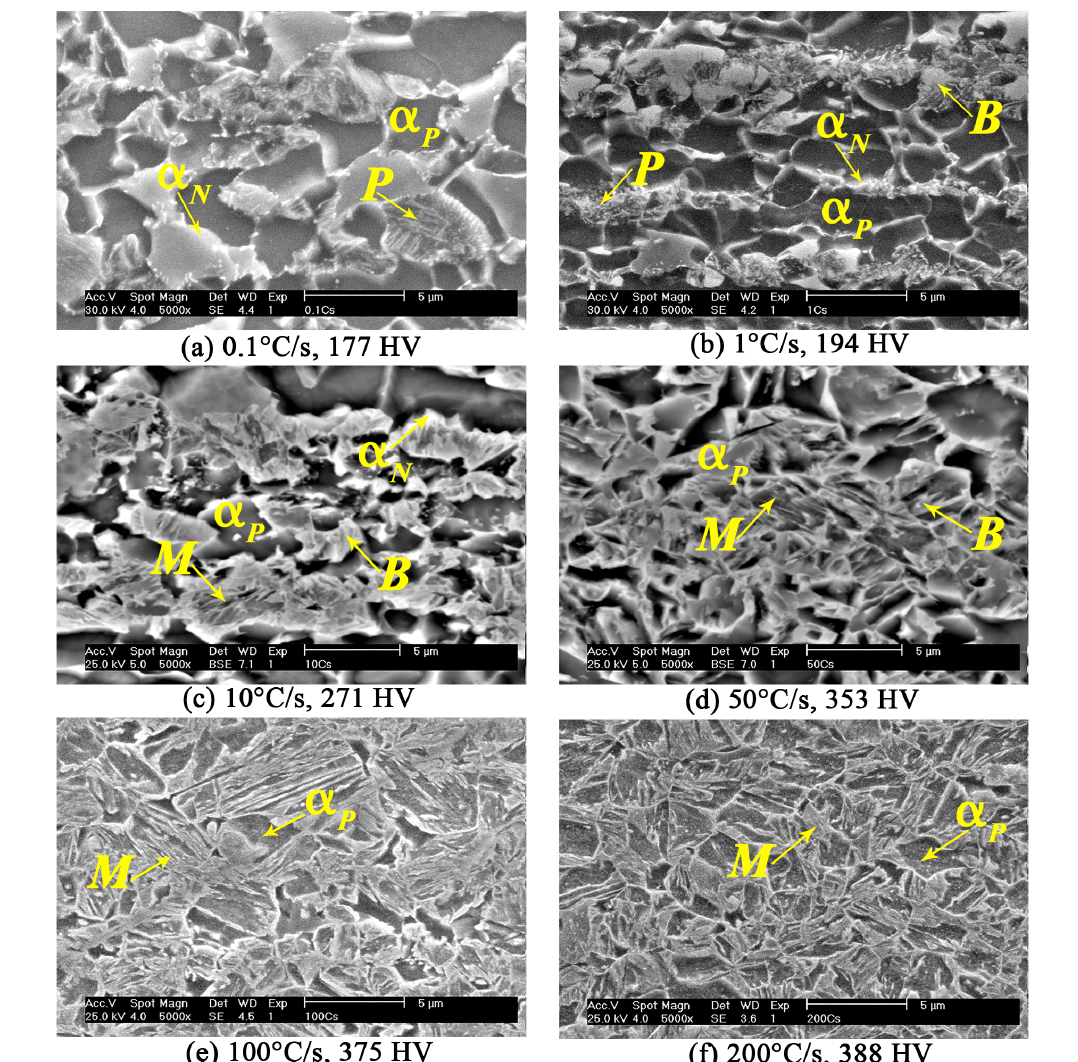
Figure 8. SEM micrographs showing the microstructural evolution as a function of the cooling rates from the intercritical temperature of 800 ◦ C: ( a ) 0.1 ◦ C/s; ( b ) 1 ◦ C/s; ( c ) 10 ◦ C/s; ( d ) 50 ◦